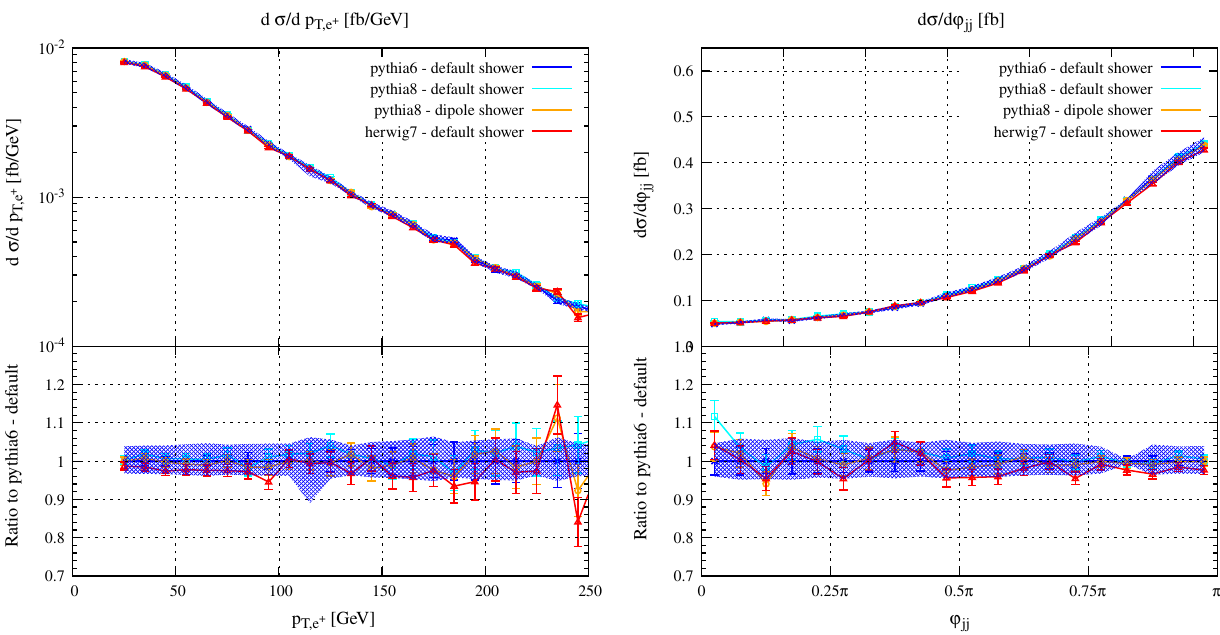
Fig. 7 Transverse-momentumdistributionofthehardestpositron(left) and azimuthal-angle separation of the two tagging jets (right) in the ATLAS-loose scenario. In the lower panels the ratio of the respective